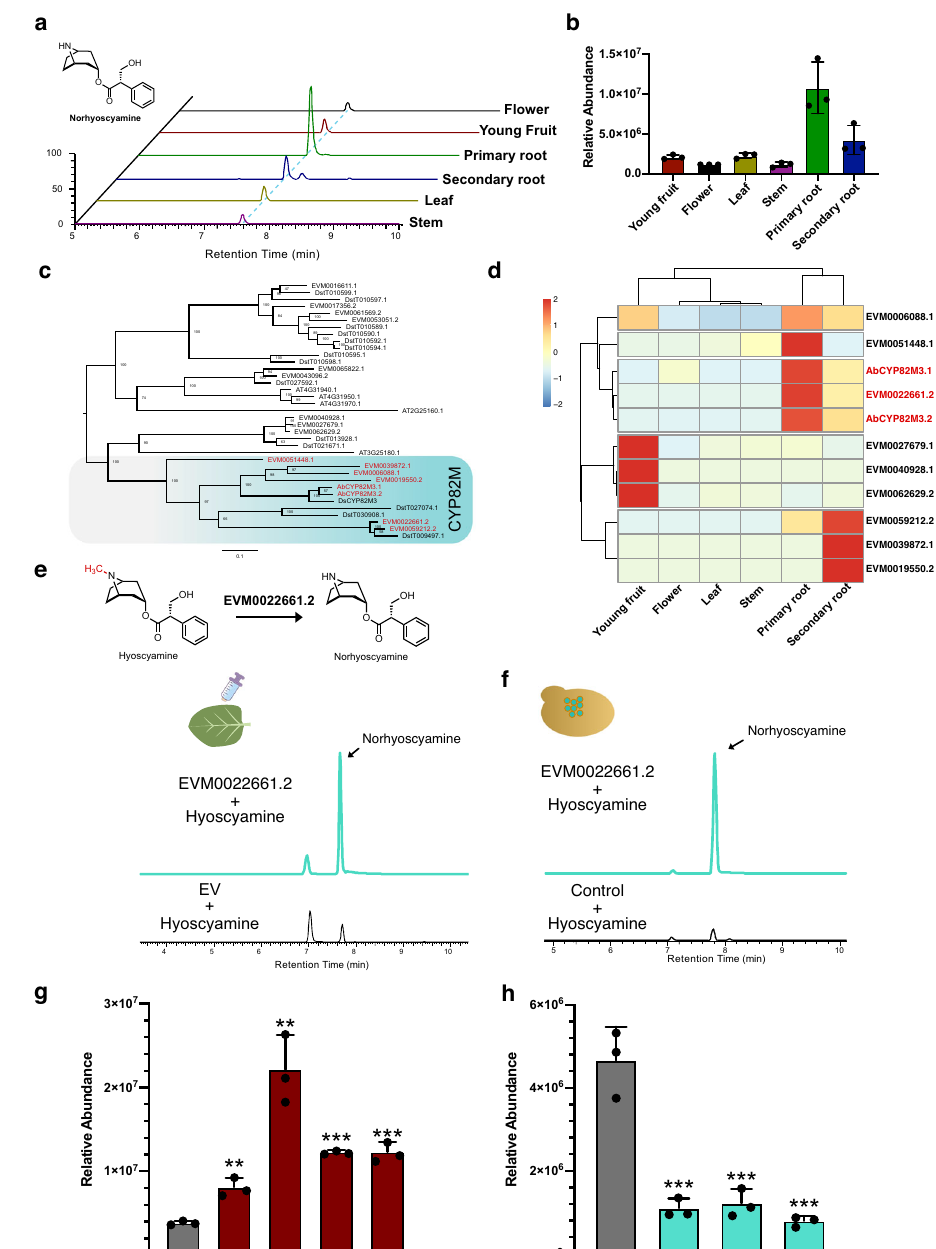
Fig.6|Characterizationofthe N -demethylaseofhyoscyaminein A . belladonna . a Analysisofnorhyoscyaminecontentindifferenttissuesof A . belladonna byUPLC- MS. The light blue line represents the retention time of norhyoscyamine. b The relative abundance of norhyoscyamine in different tissues of A . belladonna . The data are presented as means values +/ − s.d. ( n =3 biologically independent sam- ples). c The maximum-likelihood tree of the CYP82 subfamily in A . belladonna , D . stramonium and A . thaliana . The CYP82M clade is highlighted. The bootstrap support value ( n =1000) is shown on the branch. d The coexpression analysis of CYP82M family members in different tissues of A . belladonna . The expression values are scaled as TPM. e Functional identi fi cation of the N -demethylase activity of EVM0022661.2 by tobacco transient expression assays. Extracted ion chroma- tograms showing the in vivo N -demethylase activity of EVM0022661.2 in tobacco leaves. Hyoscyamine was used as a substrate by in fi ltrating tobacco leaves. f Functional identi fi cation of the N -demethylase activity of EVM0022661.2 using